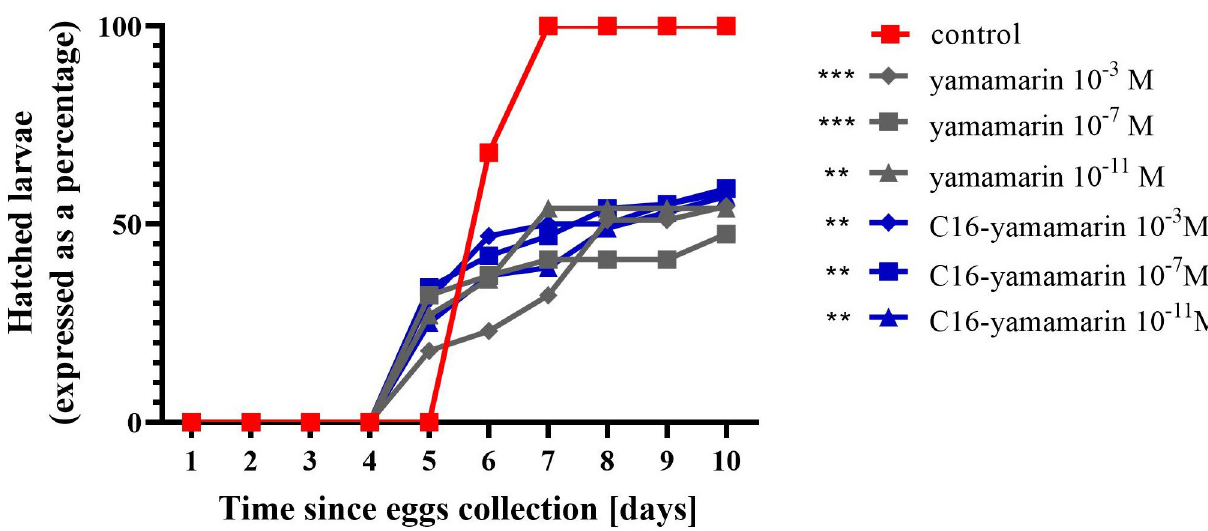
Fig 9. Duration of embryonic development and the hatchability of the next generation larvae from eggs laid by females injected with physiological saline (control), yamamarin and C16-yamamarin. Statistically significant differences (two-way ANOVA with Dunnett’s multiple comparisons test) in comparison to the control are indicated by asterisks p � 0.001 ( ��� ), p � 0.01 ( ��